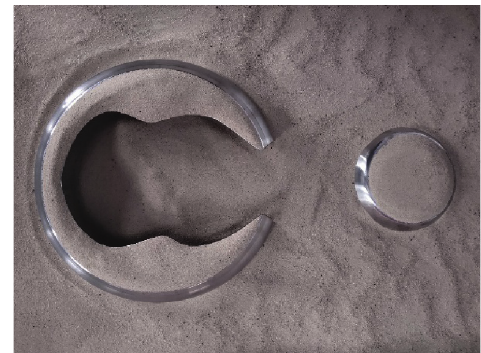
Figure 7: Photographs of the test